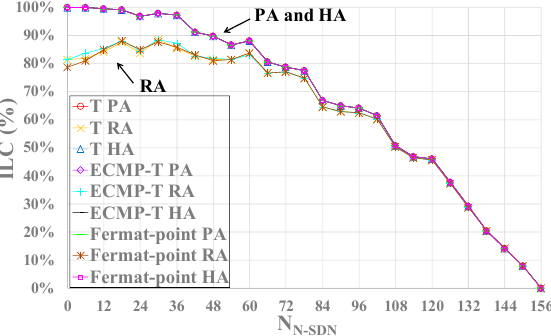
Figure 8. The impact of three approaches in three SDN interception models on ILC under CRN topologies. ILC. The higher, the better.